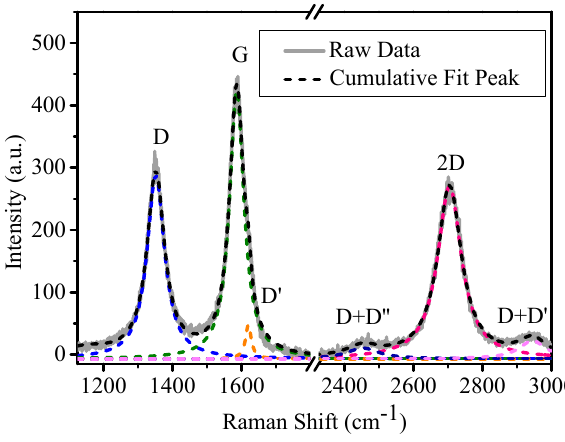
Figure 1. Raman spectrum and fitting peaks of polycrystalline graphene grown by chemical vapor deposition on the C-face of SiC substrate (CVD-EG).